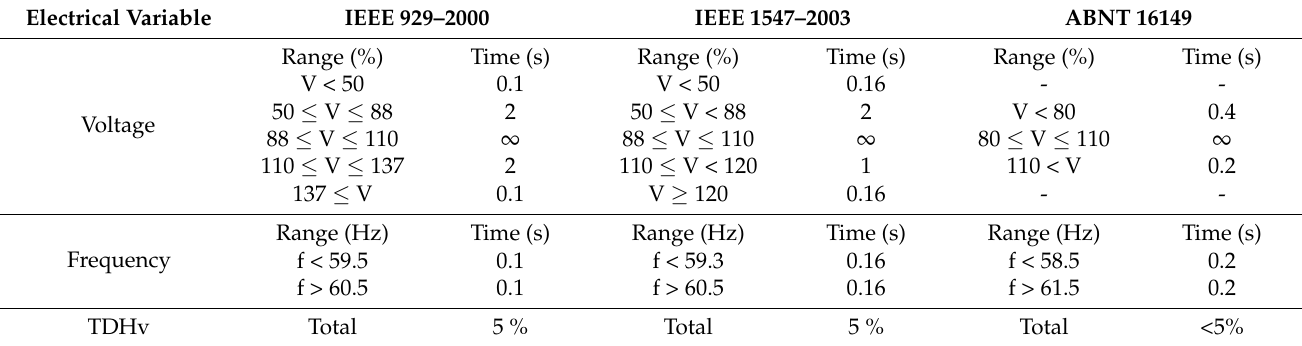
Table 2. Voltage and frequency operational allowed ranges